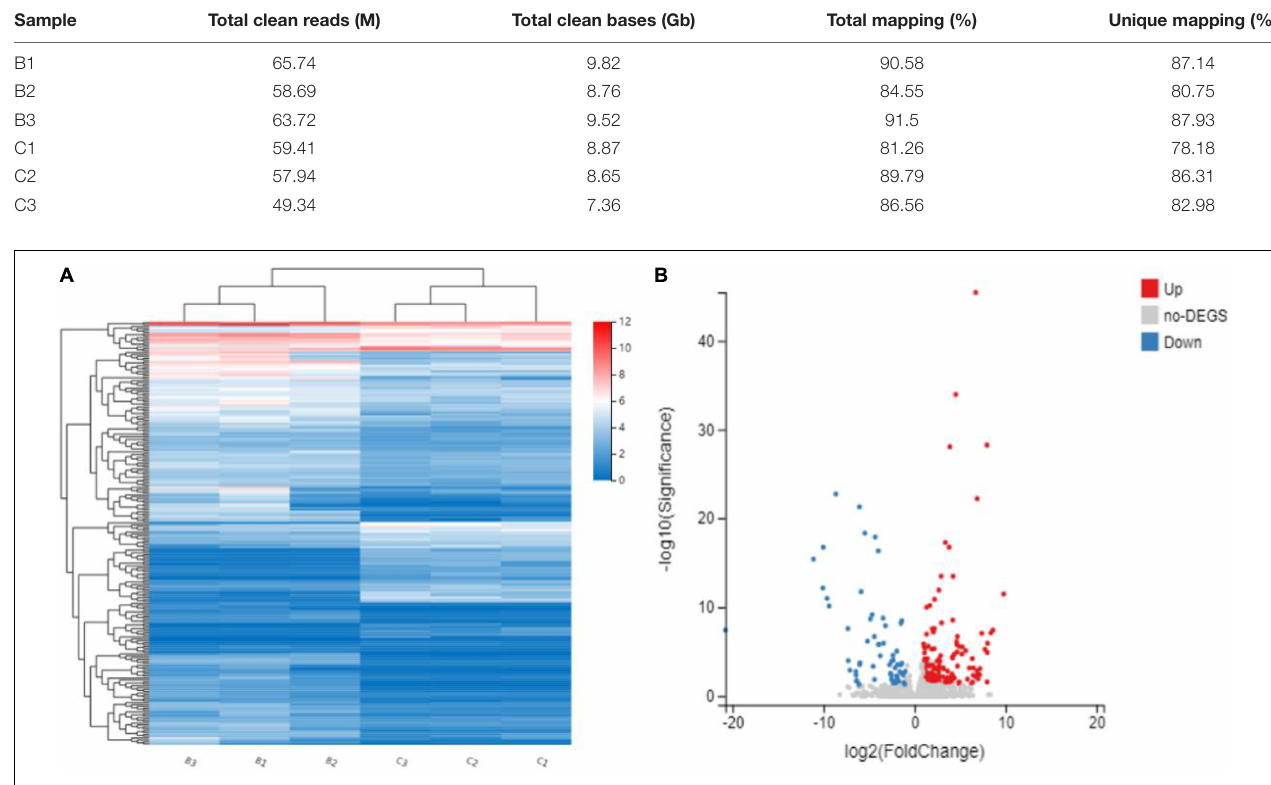
TABLE 1 | Summary of sequencing and mapping from bk5 and WT plants for RNA-seq analysis. Sample